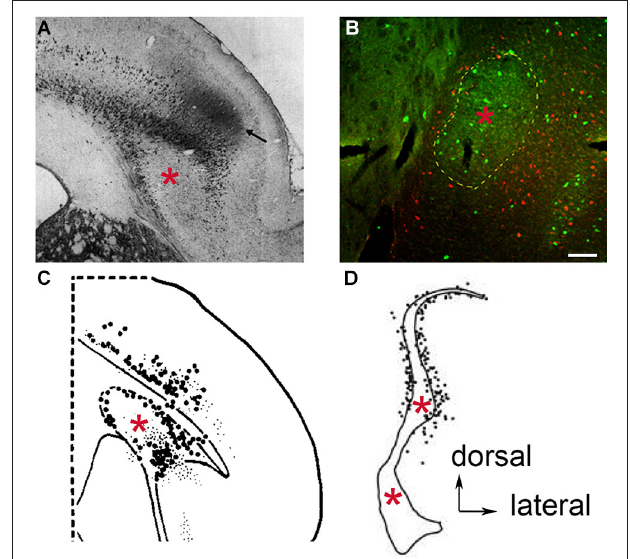
FIGURE 2 | Retrograde neuronal tract tracer labeling in the region of the claustrum following tracer deposit into the thalamic mediodorsal nucleus of various species . Examples of species lacking an extreme capsule, (A) the hedgehog, (used by permission from John Wiley and Sons; Dinopoulos et al., 1992), and (B) the rat, where PV-ir is depicted in green and retrogradely labeled cells in red (see original publication by Mathur et al., 2009). In both cases, the retrogradely labeled cells appear to reside in the insular cortex and surround the body of the claustrum (red asterisk), which in the case of the rat is defined by PV-ir. In species containing an extreme capsule, (C) the tree shrew (used by permission from Elsevier; Carey and Neal, 1986), and (D) the cynomolgus monkey (used by permission from Elsevier; Erickson et al., 2004) both exhibit a similar pattern of retrograde labeling. The rat data (B) suggests that the labeled cells in (C) and (D) are insular cortex cells that have been separated from the rest of the more superficial insular cortex cell layers through time by the development of the extreme capsule. Scale bar: 100 µ